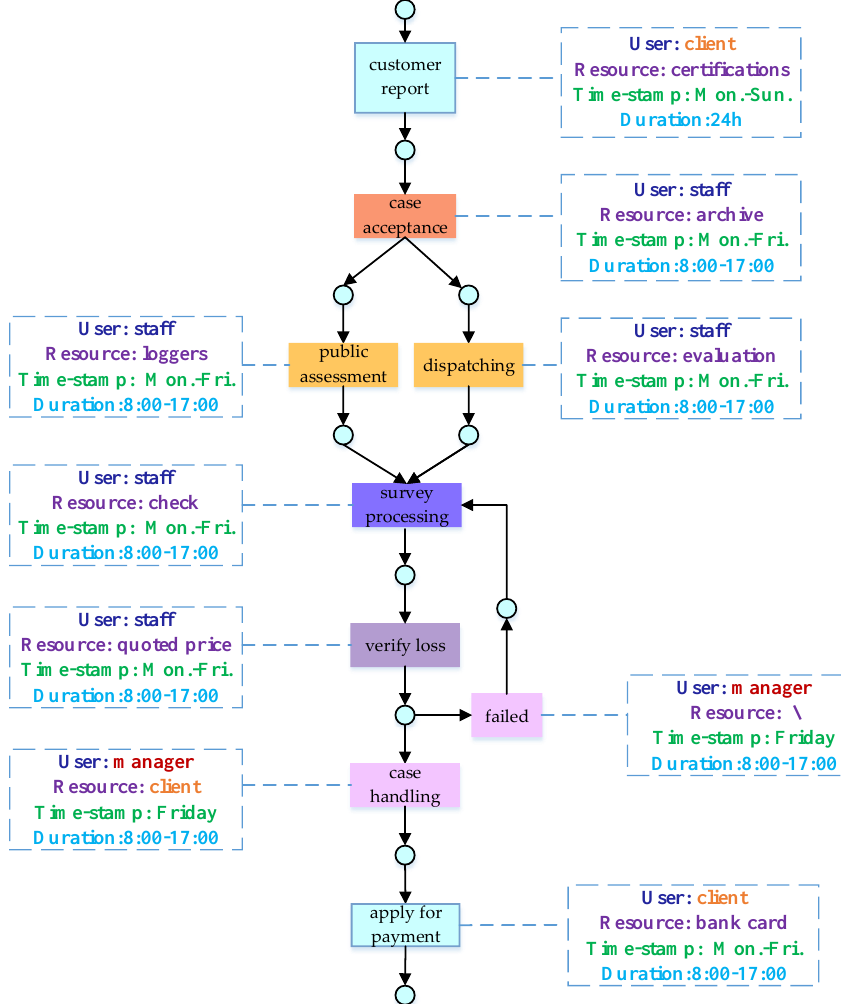
Figure 2. Petri net of insurance claim processes with data attributes of the activities. While there is various data attribute information of events in real life, only four types of attribute information are shown in the Petri diagram of this paper: User, Resource, Timestamp, and Duration. In this example, the User is divided into three roles: client, staff, and manager. The Resource is the material the User requires to execute the current